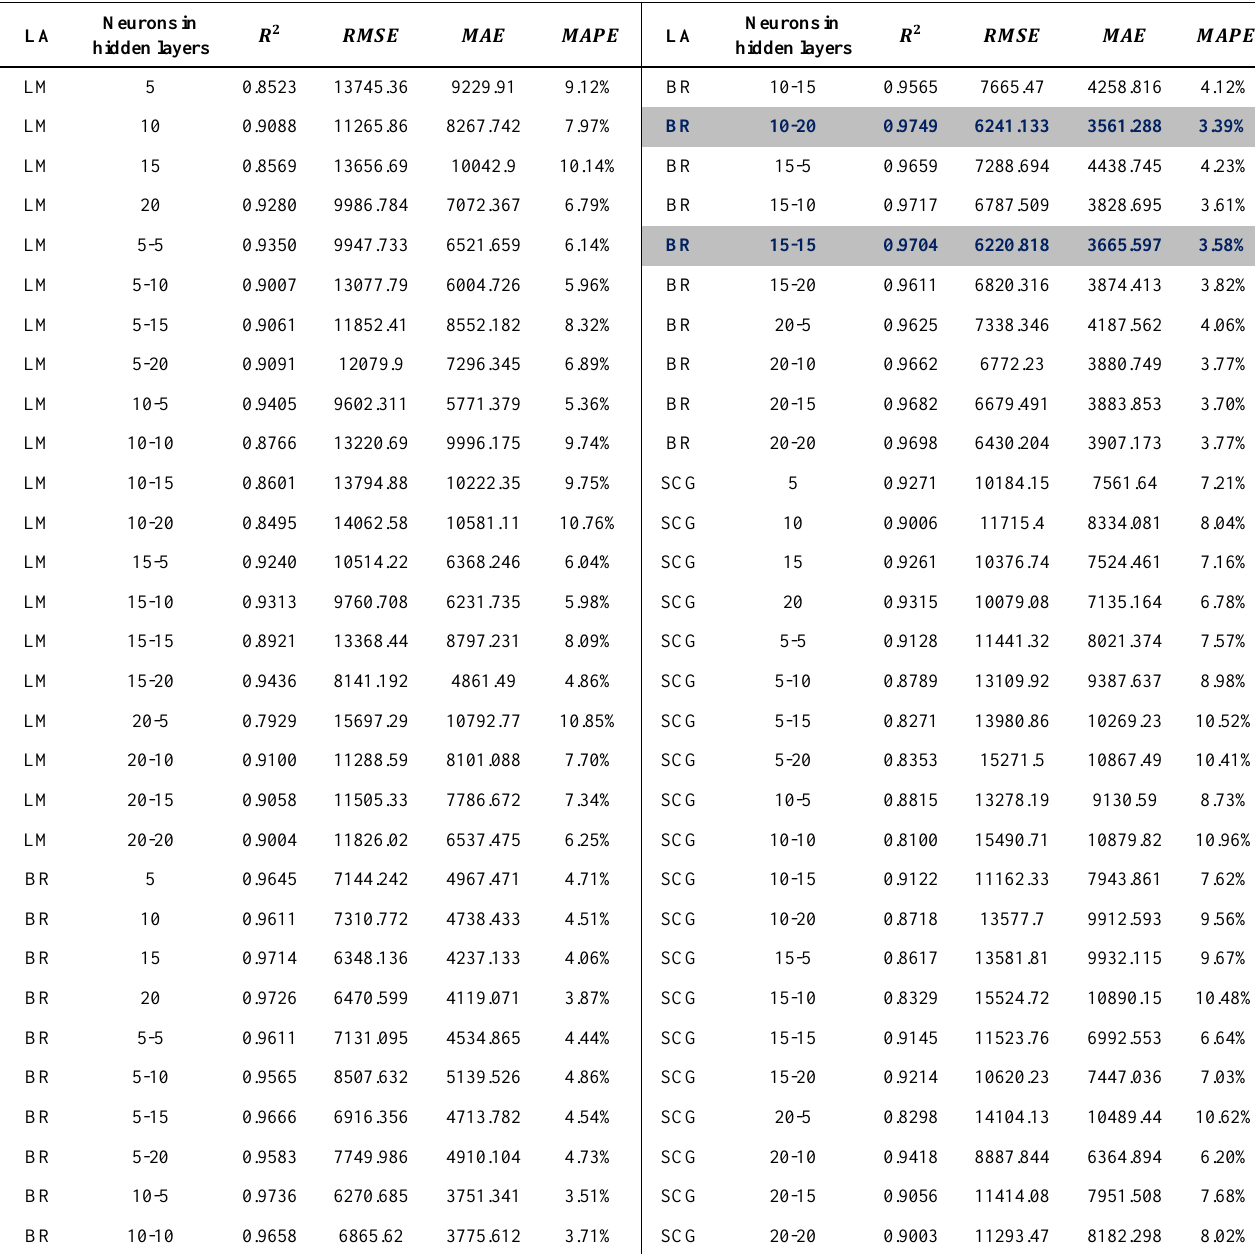
Table 4. Artificial neural networks